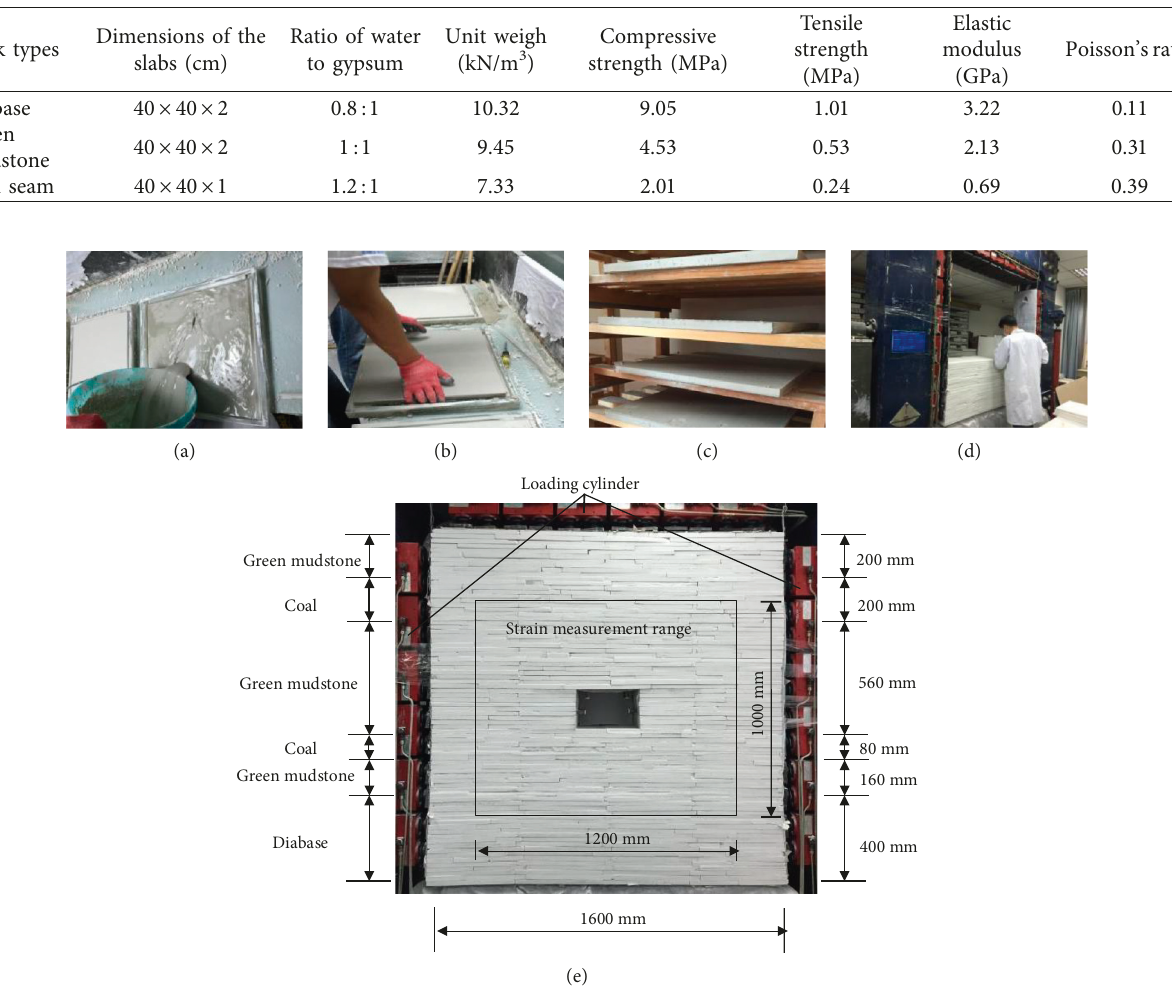
Figure 1: Elementary slabs and model making; (a) pouring of water and gypsum powder mixture; (b) demolding of elementary slabs; (c) curing of elementary slabs; (d) arranging of elementary slabs; and (e) type and range of rock mass